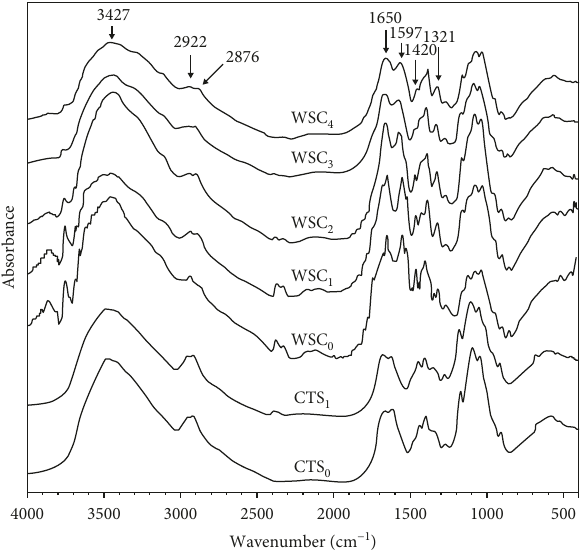
Figure 3: FT-IR spectra of the initial chitosan (CTS degraded chitosan (CTS 1 ), and WSC samples prepared from CTS 0 (WSC 0 ), CTS 1 (WSC 1 ), and degraded chitosan at doses of 3.5kGy (WSC 2 ), 10.5kGy (WSC 3 ), and 24.5kGy (WSC 4